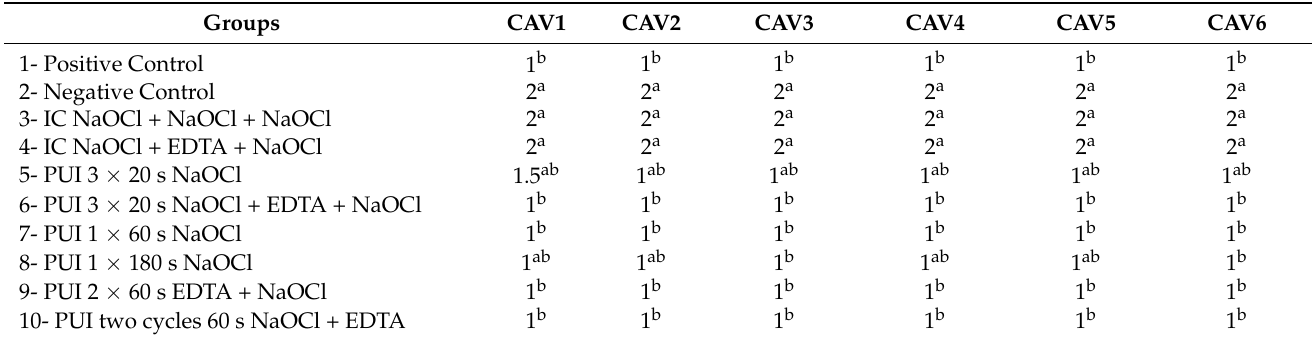
Table 3. Analysis of the dentin tubule exposure for each protocol used in every individual cavity ( p < 0.05).